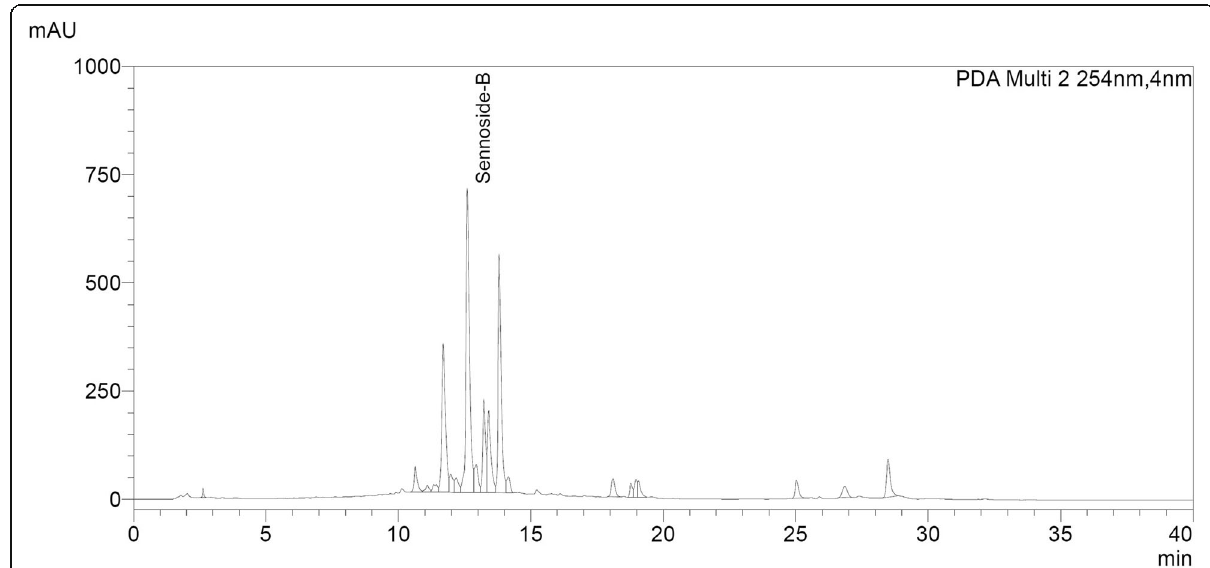
Fig. 5 HPLC chromatogram Aragvadha dry extract